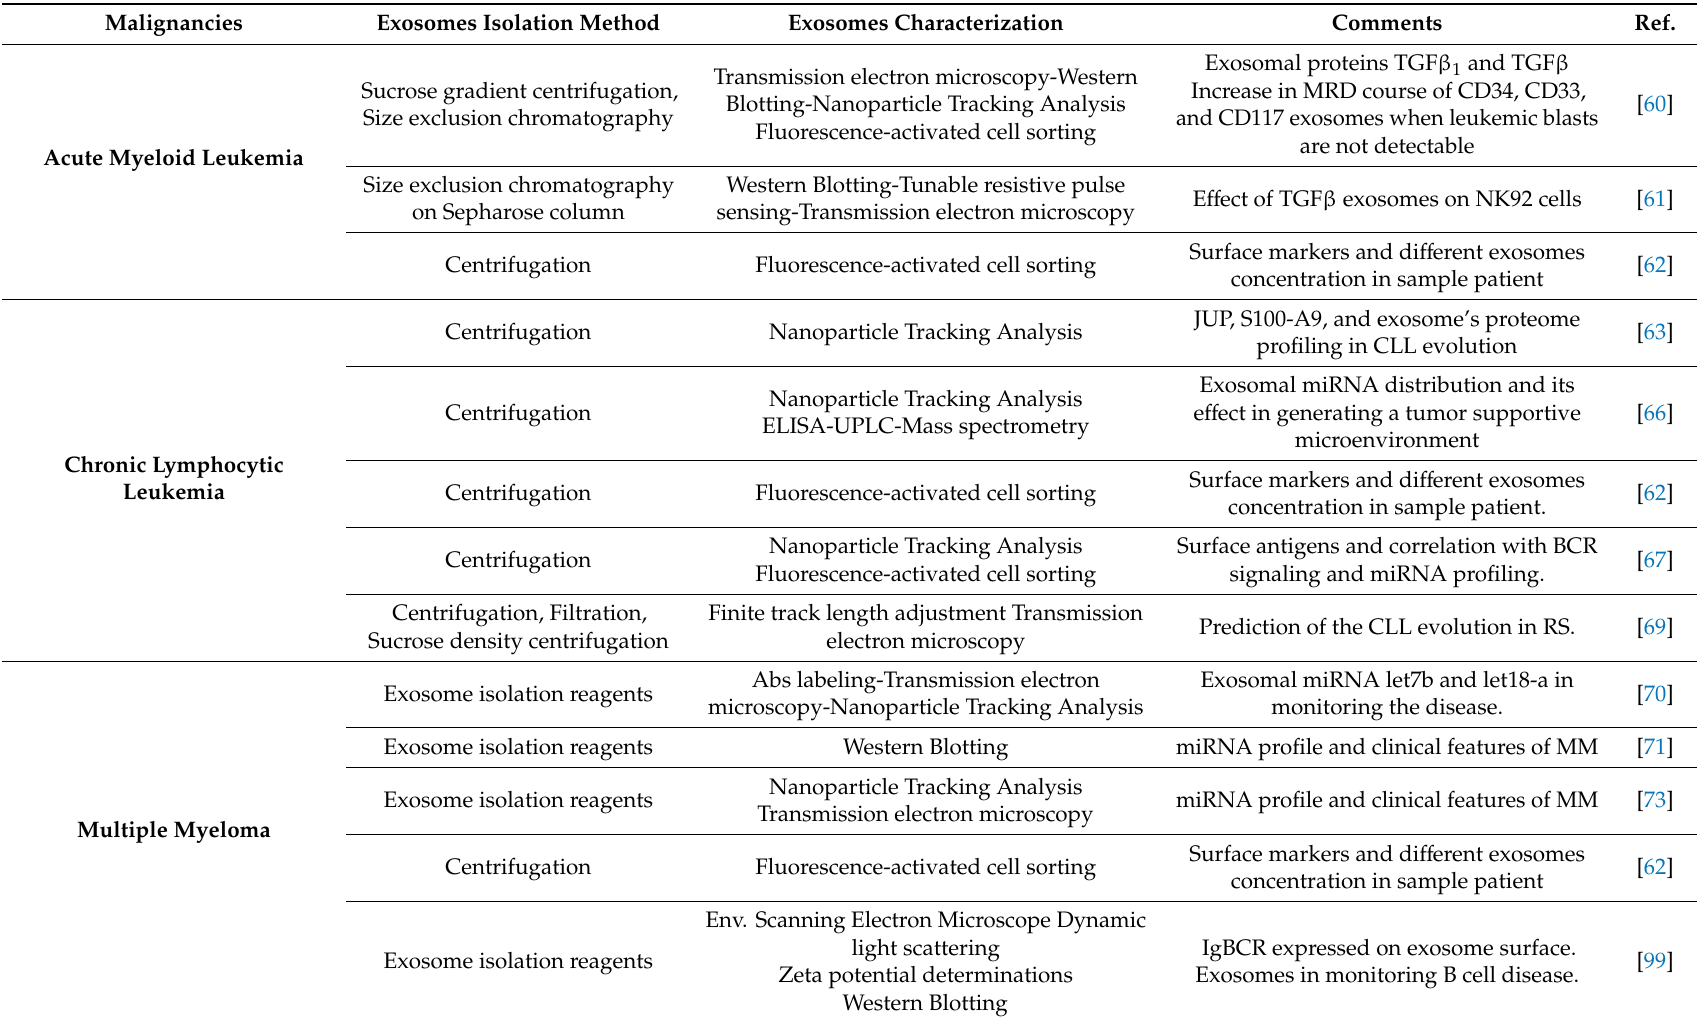
Table 2. Overview of literature highlighting the exosomes isolation and characterization approaches in cancer